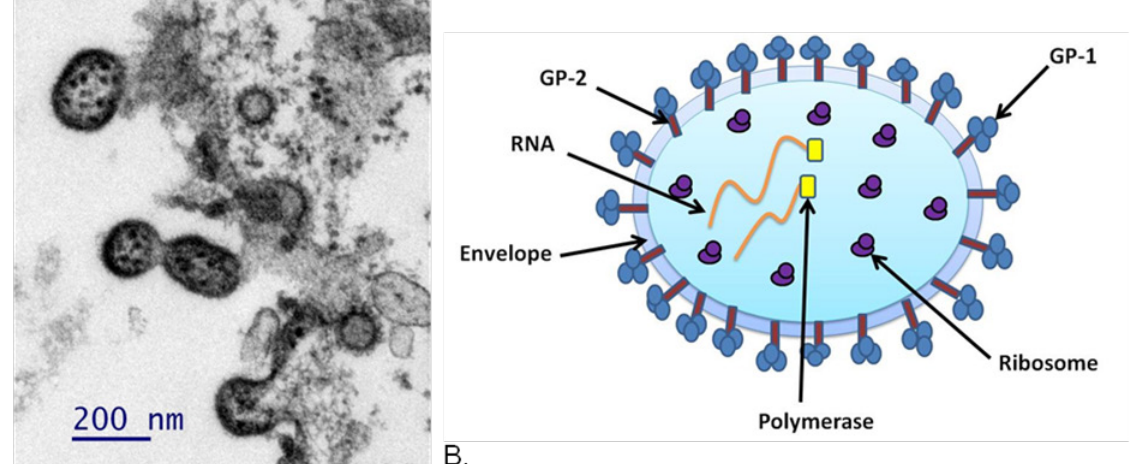
Figure 1. (a) Thin section transmission electron microscopy photomicrograph of Junín virus (JUNV) Candid#1 budding from the surface of Vero E6 cells. (b) Structure of a JUNV particle. (c) Phylogenetic tree of the Arenaviridae family. The top half of the figure shows the New World arenaviruses and the bottom half shows the Old World arenaviruses. The New World arenaviruses are separated into three different clades (A, B, and C). Genetic variation is depicted as distance. Adapted from